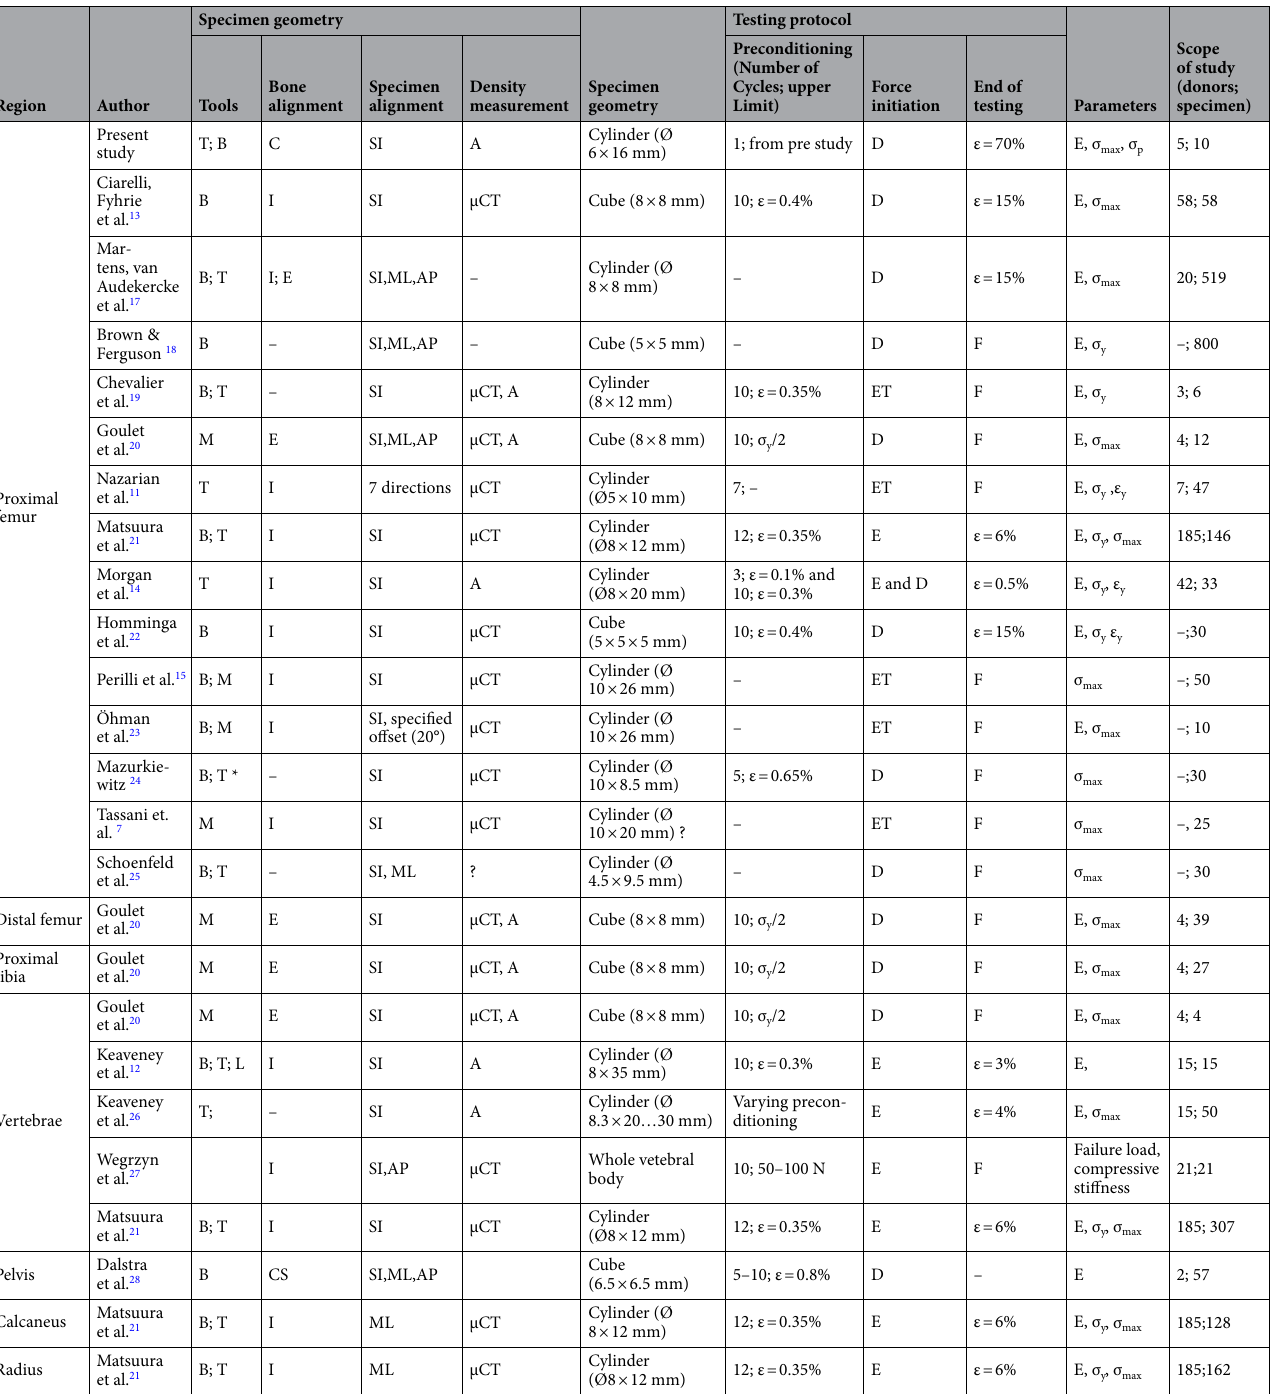
Table 3. Survey of methodological designs of published literature regarding the compressive testing of human cancellous bone categorized over examined body parts. A Archimedic principle, AP anterior–posterior, B band saw, C clamps, CS coordinate-system, D direct contact, E embedding, ET endcap-technique, F failure of material, I imaging-methods, L lathe, M milling, ML medial–lateral, SI superior–inferior, T trephine, σ max first maximum/ultimate stress, σ y yield